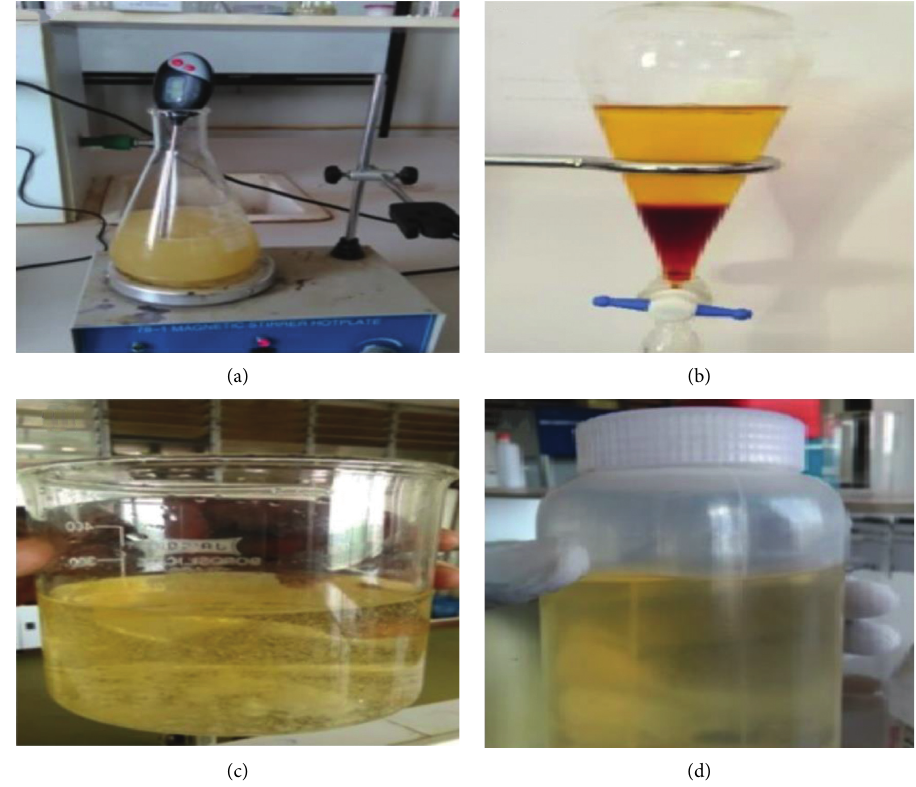
Figure 3: (a) Crude biodiesel obtained; (b) glycerol separation; (c) filtered biodiesel; (d) biodiesel after